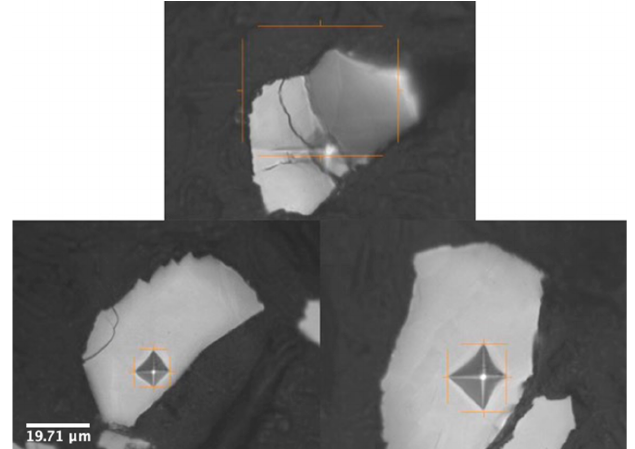
Figure 12. The three micrographs presented herein concern the use of a cold sprayable feedstock material that is much denser and harder than Al and source from Company F. Furthermore, the ( Top- most ) micrograph illustrates the inability to apply a microindentation load of 0.01 kgf to a milled/crushed, rather than gas-atomized, pure feedstock embedded in another compression mounting matrix that was even less compliant than the phenolic resin associated with Figure 11. The bottom of the set of micrographs in Figure 12 ( Left ) and ( Right ) highlight the occurrence of inclination as a secondary indentation occurs after a particle-dominated depth limit was crossed. The scalebar embedded in the ( Left ) micrograph applies to all three micrographs presented.